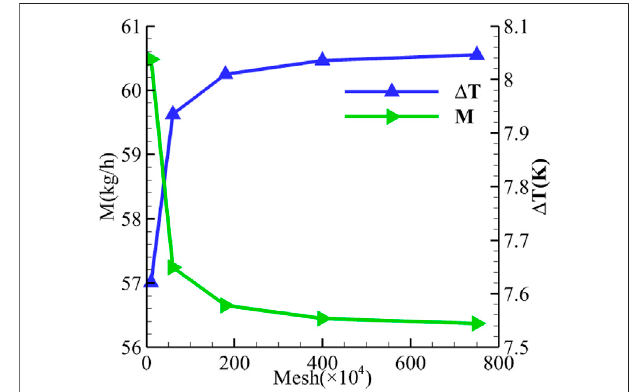
FIGURE 4 | Variation of M and Δ T as the mesh